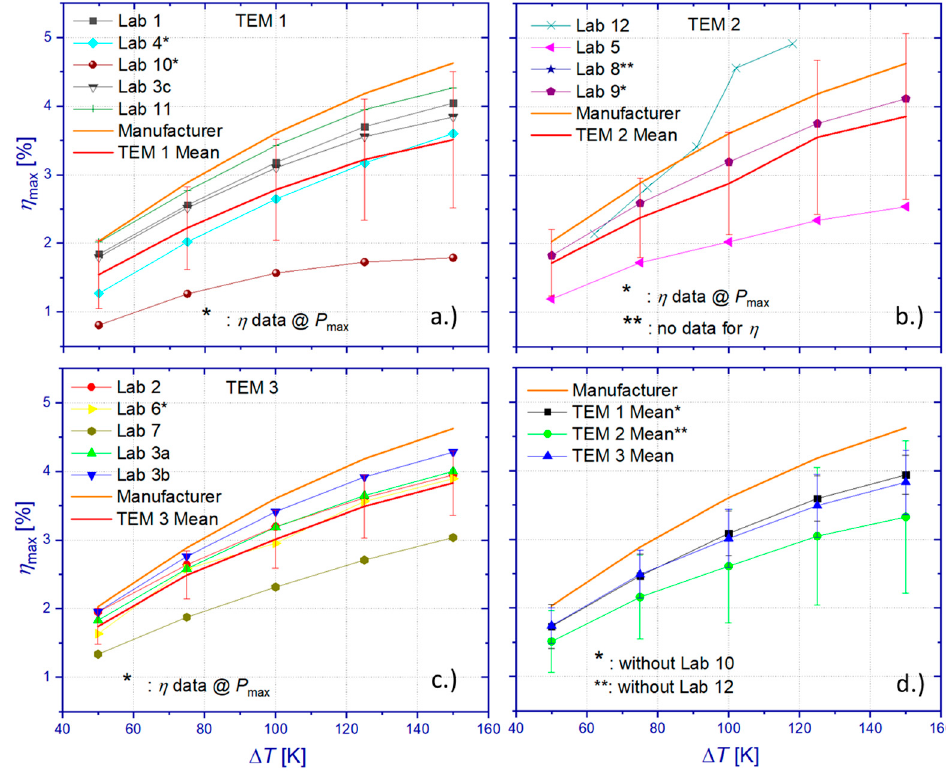
Figure 13. RR results for the maximum efficiency η max versus temperature difference ∆ T shown separately for TEM1 ( a ), TEM2 ( b ), and TEM3 ( c ). Mean values and standard deviation, displayed as error bars, have been calculated from all data sets of each TEM. Missing data sets or specification of efficiency at maximum power as well as manufacturer specifications are indicated. Mean values of the TEM are compared in ( d ).